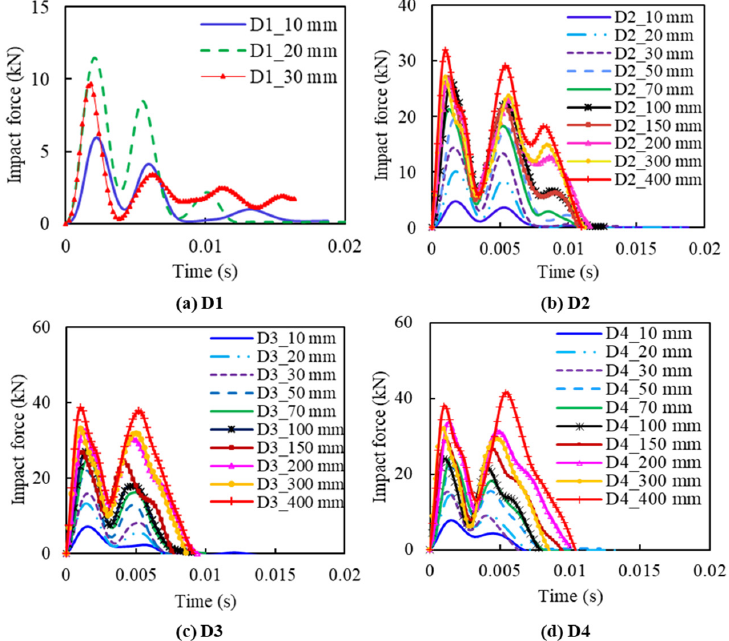
Figure 12. Impact force histories under different impact height for Group D: ( a ) specimen D1; ( b ) specimen D2; ( c ) specimen D3; ( d ) specimen D4.